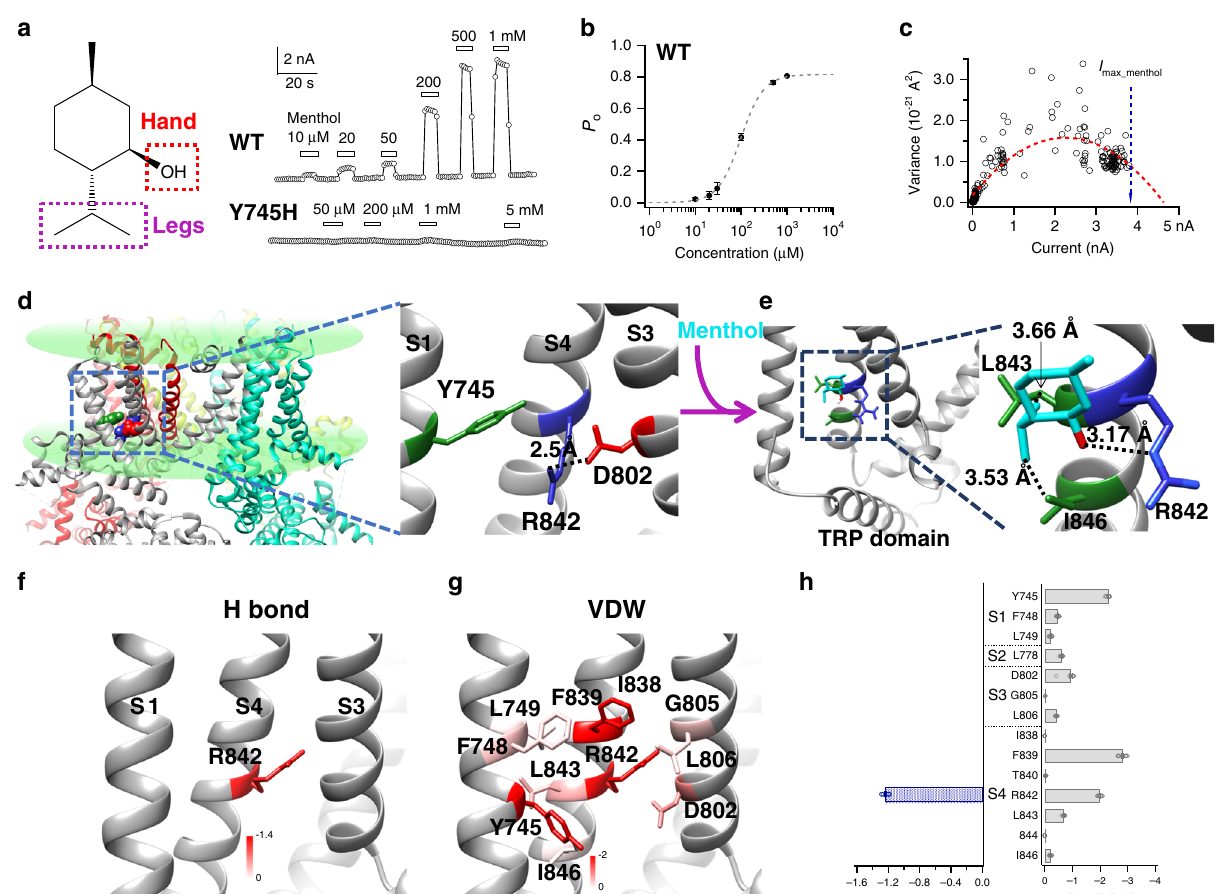
Fig. 1 Potential menthol – TRPM8 interactions revealed by docking. a The chemical structure of ( − )-menthol, where its hydroxyl and isopropyl moieties are named as hand and legs, respectively. Menthol activated TRPM8 channel in a concentration-dependent manner in whole-cell patch-clamp recordings. b The concentration – response curve of menthol activation measured from whole-cell patch-clamp recordings ( n = 5). c The maximum open probability ( P o max ) was determined from noise analysis of menthol-induced TRPM8 current. The measured maximum current ( I max_menthol ) was normalized to the predicted maximum current to derive P o max . d The putative menthol-binding pocket located within the transmembrane domains of TRPM8 channel as revealed by cryo-EM. The zoom-in view of the binding pocket illustrated that residues known to be critical for menthol activation are tightly packed in the apo state (PDB ID: 6BPQ). e Docking of menthol into the binding pocket in the WS-12-bound activated state (PDB ID: 6NR2) lead to disruption of residue packing. The hydroxyl hand of menthol is predicted to form a hydrogen bond with the sidechain of R842 (dashed line in red). f – h Breakdown of the menthol-binding energy ( h ). The per-residue energy contributed by hydrogen bonding ( f ) and VDW interactions ( g ) was mapped onto the structure of TRPM8, respectively. The redder in color scale indicates larger energy value in REU (Rosetta energy unit). All statistical data are given as mean ± s.e.m. Source data are provided as a Source Data